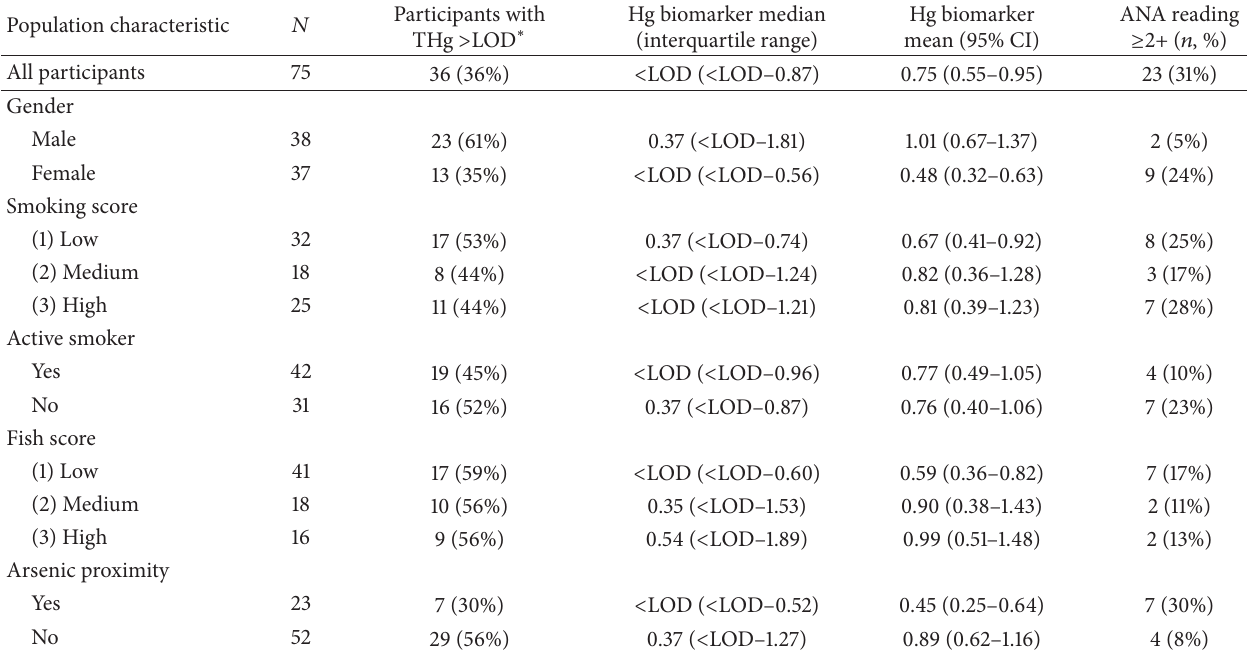
Table 1: Biomonitoring and ANA ≥ 2+ results linked with study participant characteristics.